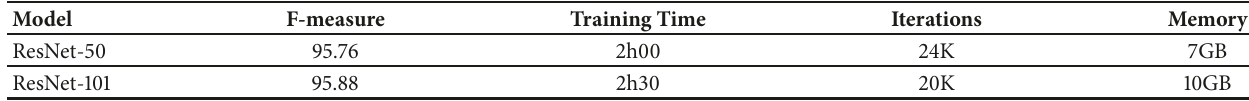
Table 2: Comparative results of deeper models performance.